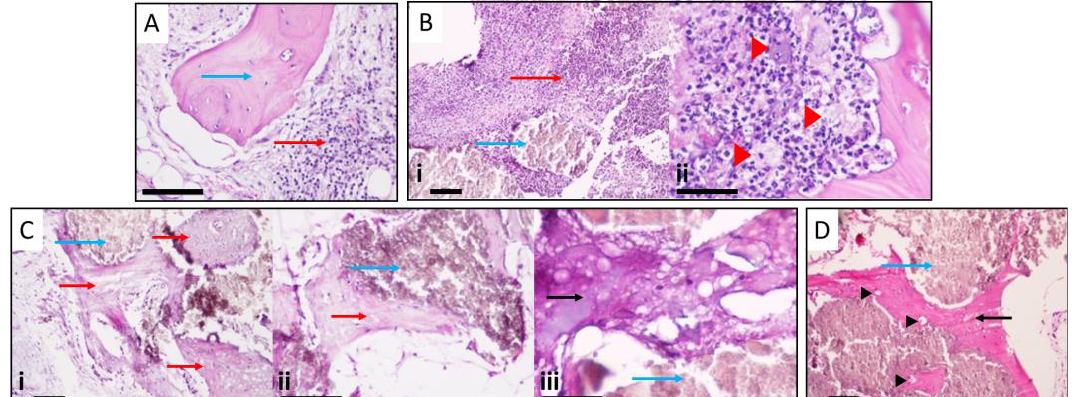
Figure 6. ( A ) Presence of mononuclear inflammatory infiltrate compatible with chronic osteomyelitis and some foci of the polymorphonuclear cell infiltrate (red arrow), close to or surrounding bone tissue (blue arrow), suggesting acute infection. ( B ) The predominance of polymorphonuclear and suppuration (red arrow) around biomaterial (blue arrow). Giant cells are also visible (red arrowheads), suggesting a foreign body reaction. ( C ) V-HEPHAPC (blue arrows) is surrounded by a chondroid matrix (red arrow) and bone, with osteocyte visualization. At higher magnification, very little inflammatory infiltrate and ossification can be clearly seen. In the X200 and X400 images, the biomaterial (blue arrow) is surrounded by chondroid (red arrow) and bone matrix (black arrow) with an area of still-immature bone formation. ( D ) At the periphery of the material (blue arrow), the appearance of bone tissue (black arrow) with numerous osteocytes (black arrowheads) is clearly visible, with zones of calcification and bone maturat ion. Scale bars = 500 μm ( Ci ); 100 μm (( A ), ( Bi ), ( Cii ), ( Ciii ) and ( D ) ); and 50 μm ( Bii ).